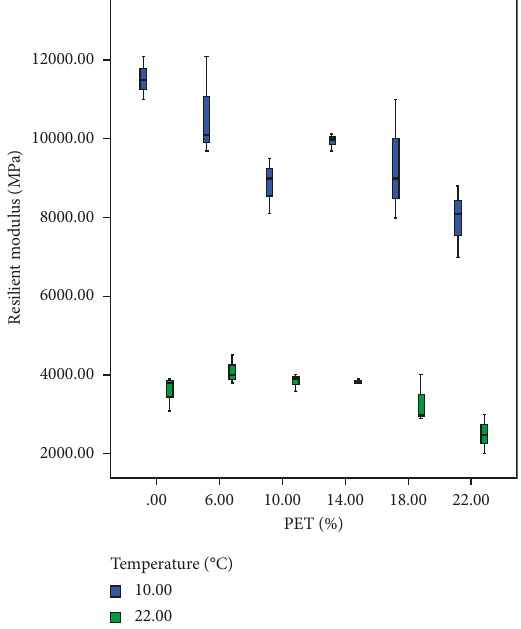
Figure 9: Resilient modulus adjusted for different percentages of PET at 10 and 22 °